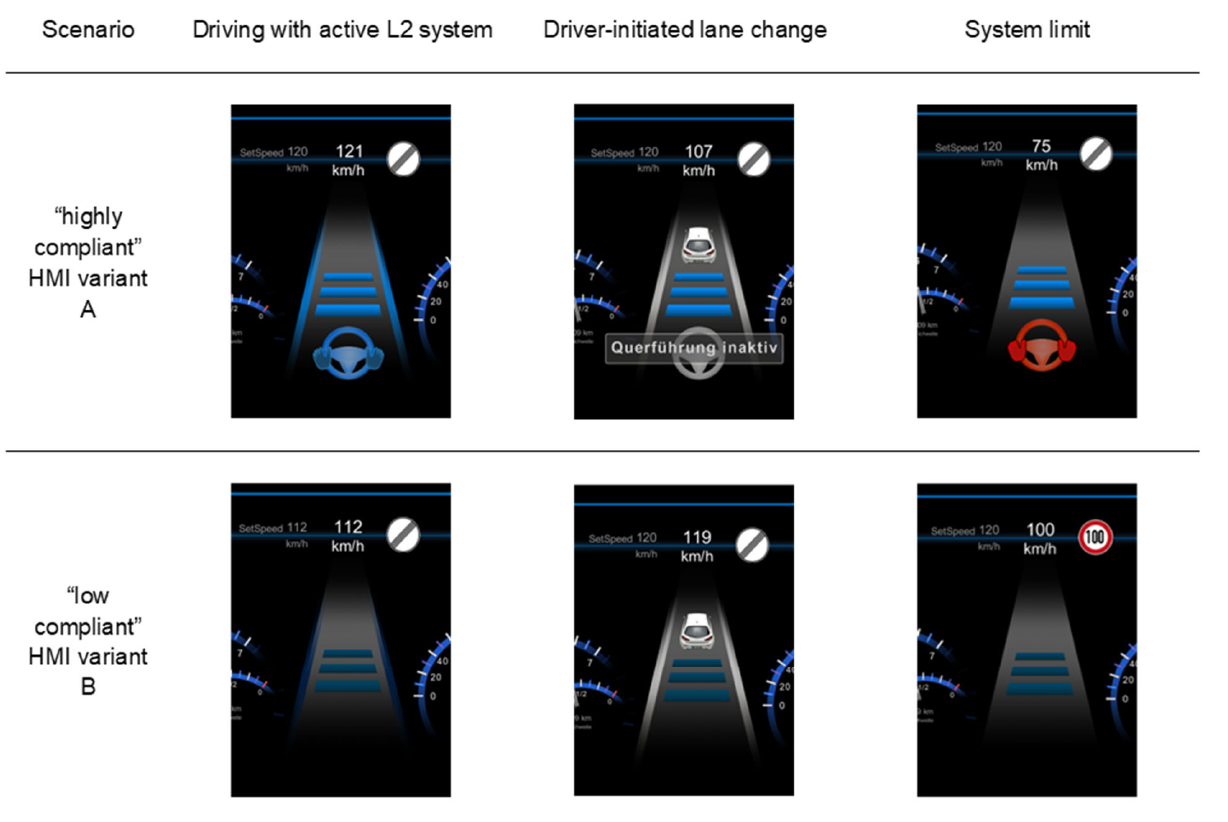
Figure 3. Exemplary scenarios in which the HMI variants differed with regard to system outputs.